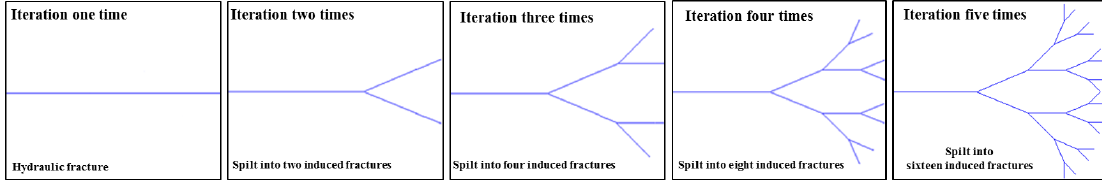
Figure 5. Fractal geometry design for one stage (bifurcation angle is 45°) .